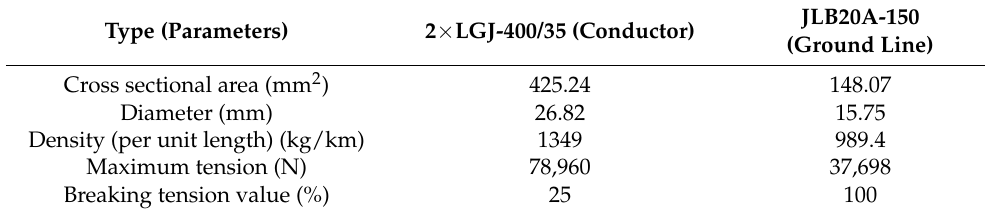
Table 1. Properties of conductor and ground